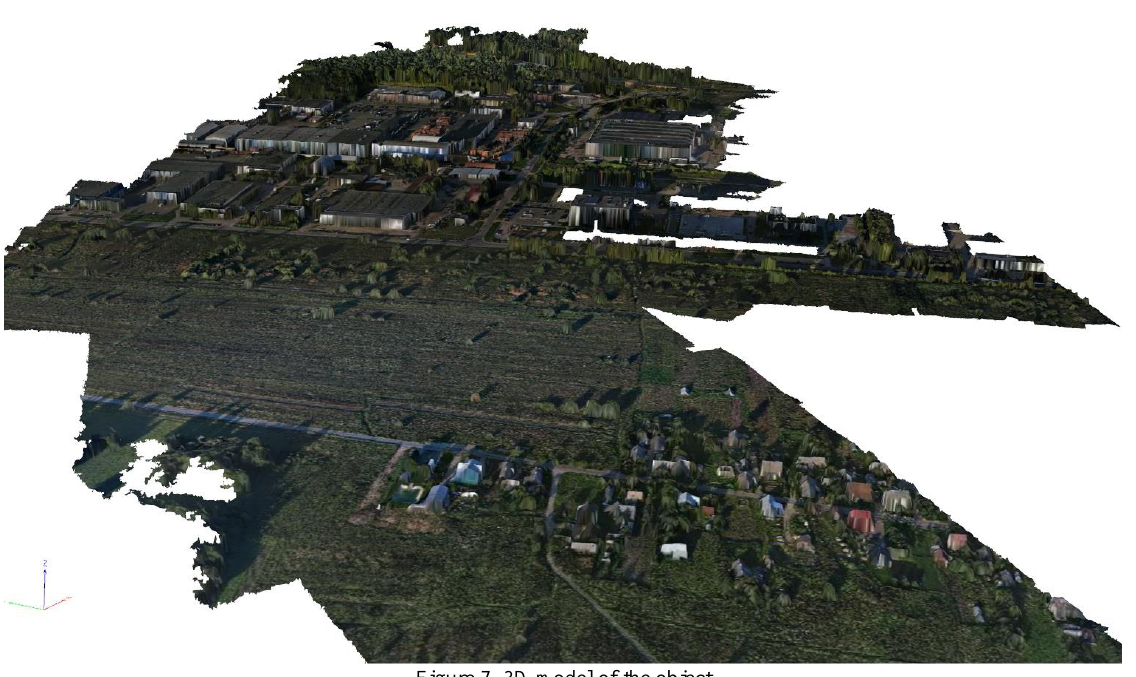
Figure 7. 3D model of the